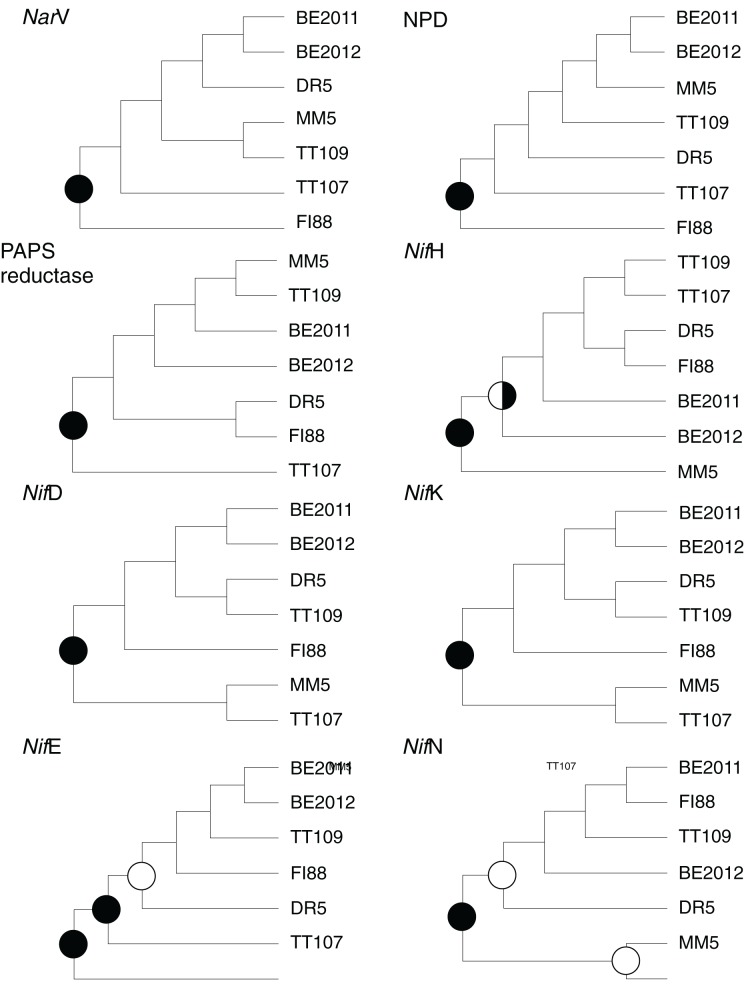
Phylogenetic relatedness of the studied metagnomes revealed by each of the common functional genes. Branch support of the dendrograms was derived from 1000 permutations of Jackknife resampling. Nodes supported by 50–69% (open circles), 70–89% (half-filled circles), and 90–100% (filled circles) of the permutated trees are indicated.